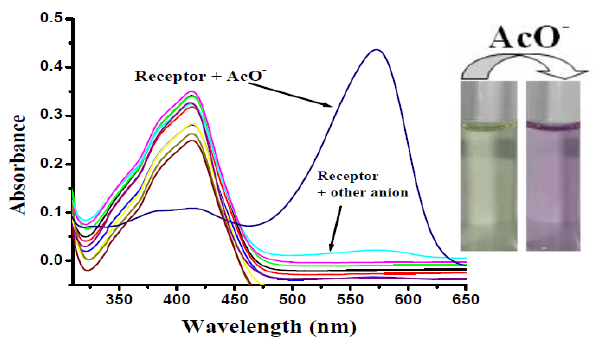
Figure 22: UV-vis absorption spectra of R 34 (C= 1x 10 -5 M) upon titration with TBAA (tetrabutylammonium acetate) (C= 2x 10 -4 M) in CH 3 CN at 25 0 C. Inset: Non-linear 1:2 fitting isotherm recorded at 573 nm. (adapted from ref.71e).